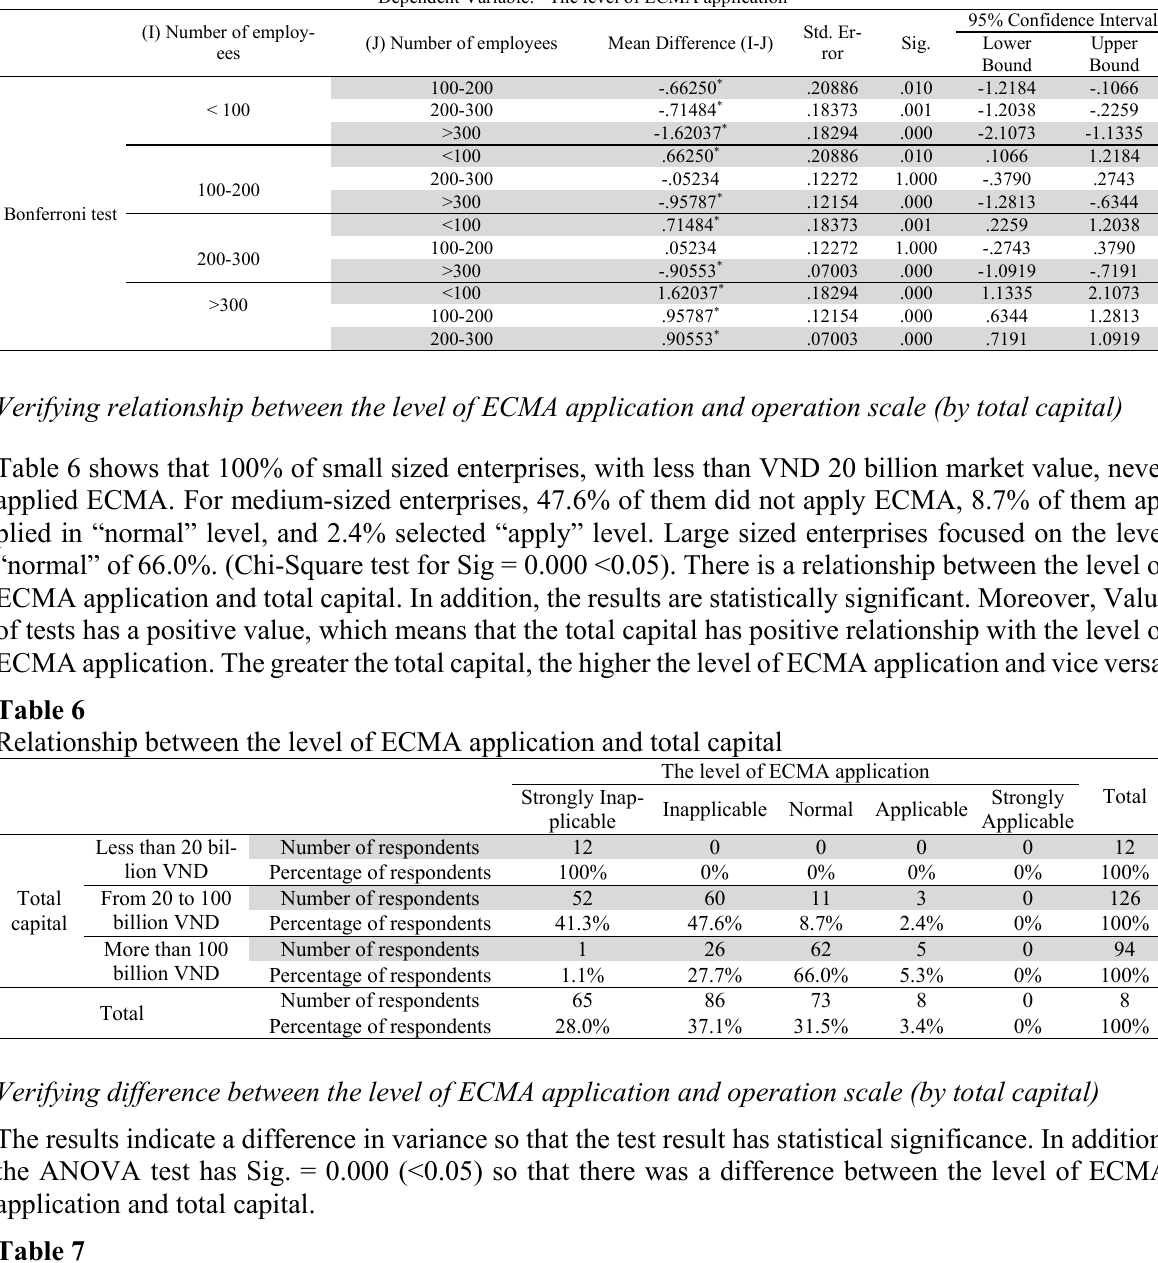
Verifying difference between the level of ECMA application and total capital Multiple Comparisons Dependent Variable: The level of ECMA application